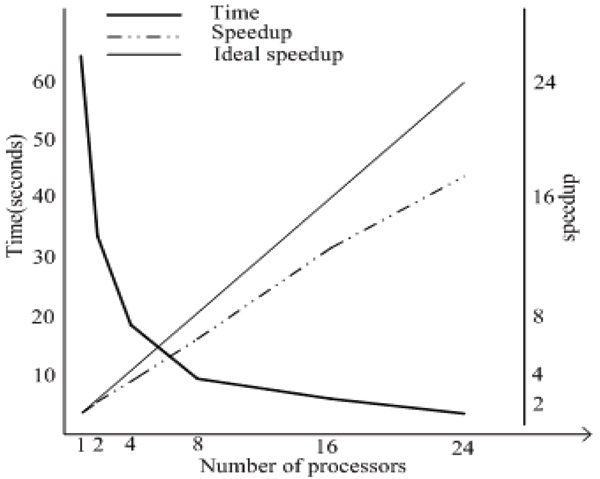
The execution time and speedup of PMC-SVM on sweetgum with Dataset 1 (Letter_scale).